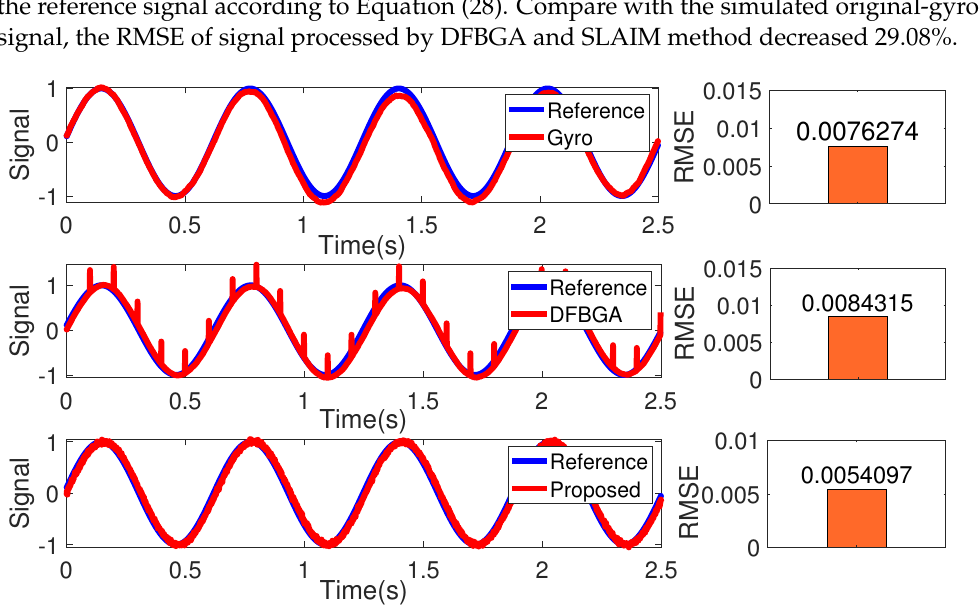
Figure 6. Simulation results of signal process based on Kalman filter. The first subfigure is the simulated original-gyro signal, the second subfigure is the signal processed by DFBGA, the third subfigure is the signal processed by DGBGA and SLAIM.